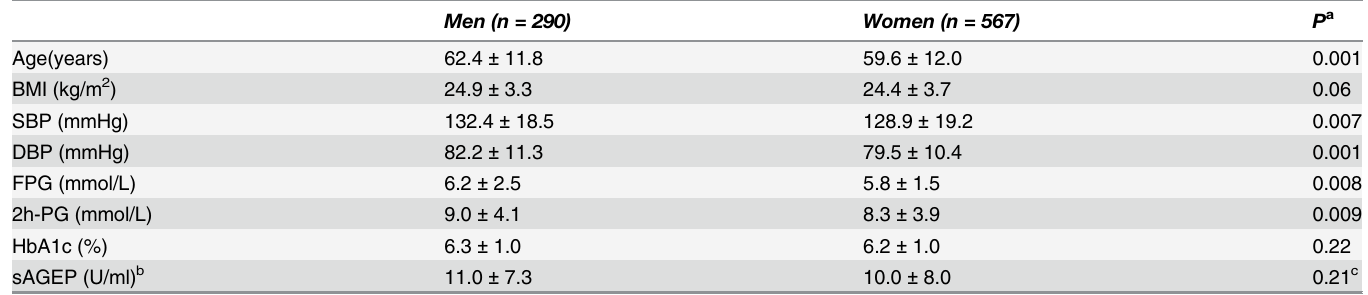
Data are presented as means ± standard deviations. a Compared between men and women. b Samples for measuring sAGEP were taken from 856 subjects with 290 men and 566 women. c Compared between men and women with adjustment for age.